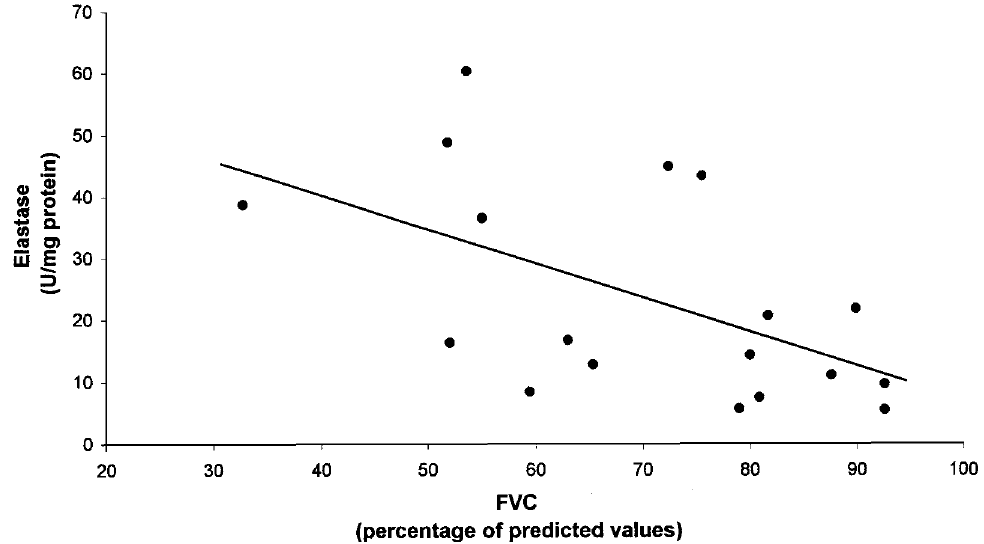
FIG. 2. Association betweeen lung elastase activity and forced vital capacity (FVC) in CF patients. The relationships between protease activity and FVC were analyzed by using Spearman rank correlation ( R = ± 0.536; p <0.04).